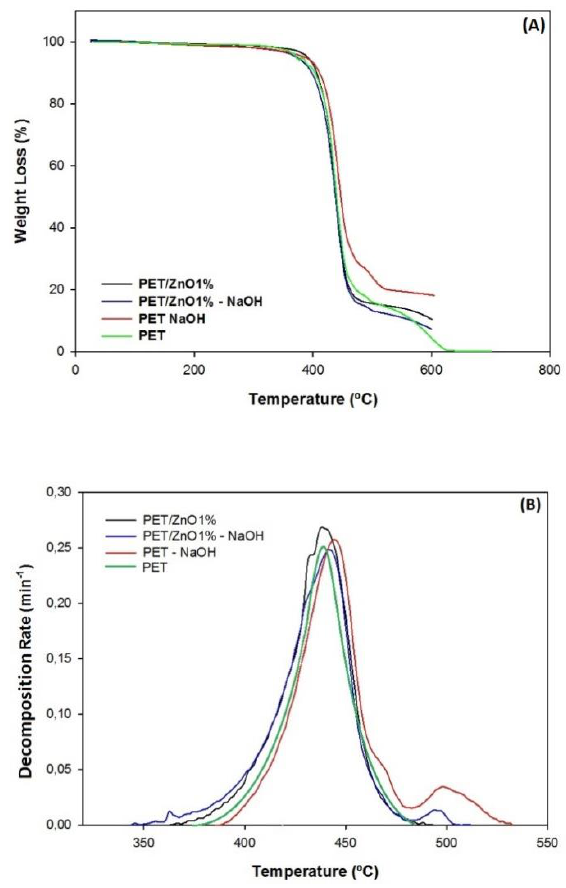
Figure 6. TGA plots of the compounds under study. ( a ) Weight loss. ( b ) Decomposition rate. Table 3. Thermodynamic and kinetic parameters of decomposition computed from TG scans. Compound